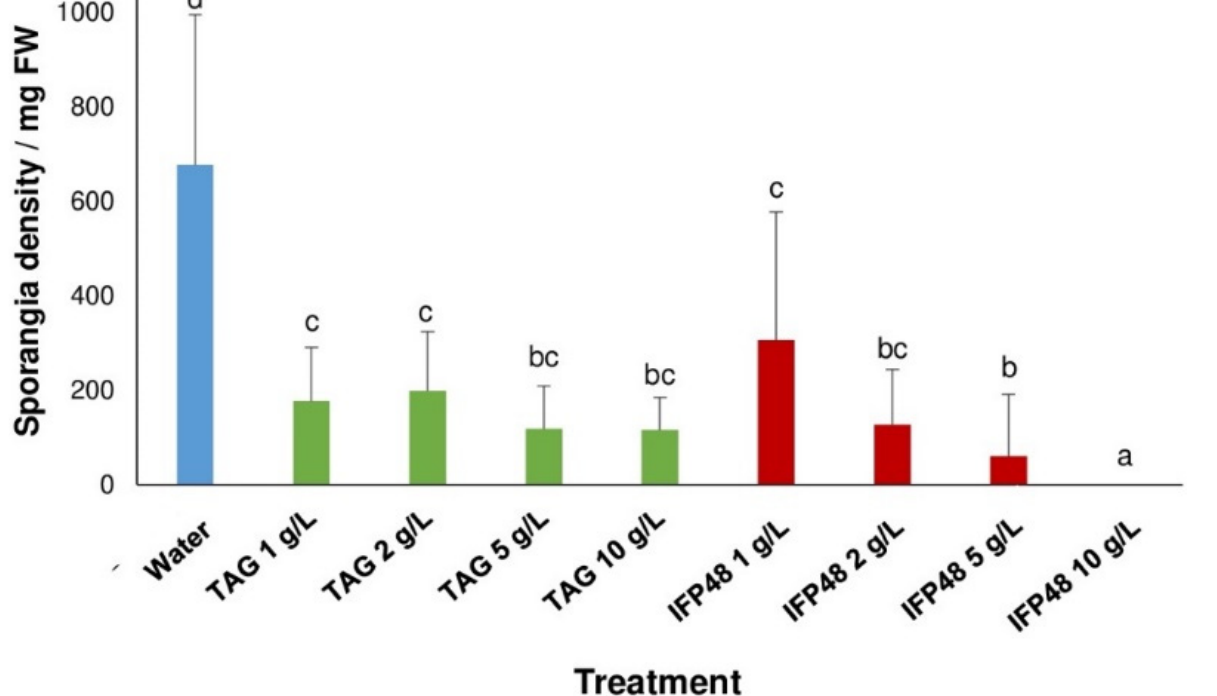
Figure 3. Downy mildew disease severity in grapevine leaves after aerial part treatment with D- tagatose and IFP48. Shoots of in vitro-grown grapevine plantlets were treated with 1, 2, 5, and 10 g/L D-tagatose-based formulated product (IFP48) or pure D-tagatose (TAG). As control, plants were treated with water. Leaf inoculation was carried out at one day post treatment (1 dpt) and disease severity was evaluated by counting the Plasmopara viticola sporangia at eight days post inoculation (8 dpi). Data are means ± SD from eight plants with five leaves per plant and three independent experiments that showed similar results. Different letters indicate significant differences according to the one-way ANOVA Welch’s test with Student’s t -test ( p ≤ 0.05). 5.2. IFP48 and TAG Exert a Direct Effect on P. viticola Sporangia Spray treatment of detached leaves showed direct anti-oomycete activity of IFP48